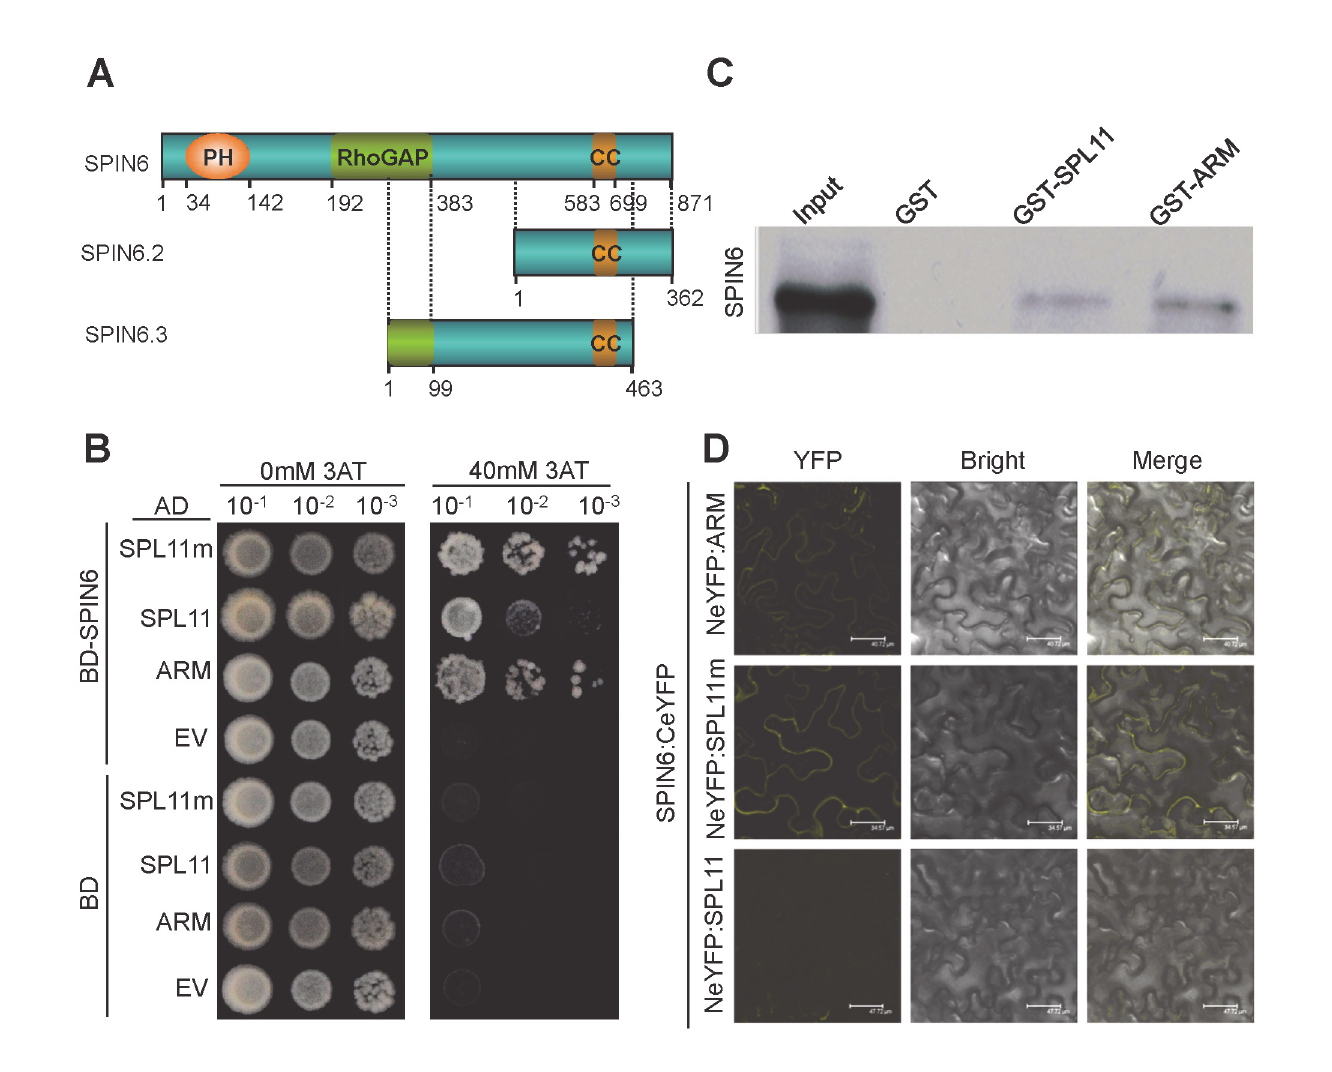
Figure 1. SPIN6 is a Rho GTPase-activating protein (RhoGAP) and interacts with SPL11 in vitro and in vivo . (A) The protein structure of SPIN6, SPIN6.2 and SPIN6.3. The position of the Pleckstrin Homology (PH) domain (34 – 142), RhoGAP domain (192 – 383), and coiled coil (CC) motif (583 – 699) are indicated. (B) SPIN6 interacts with SPL11 in yeast. SPL11 represents the full-length SPL11; ARM is the ARM domain of SPL11; and SPL11m is the SPL11 mutant with a three amino-acid deletion at C314P315T316 in the U-box domain, resulting in a loss-of-function of E3 ligase activity (Zeng et al., 2004). After they were diluted 10, 100, and 1000 times with sterilized-distilled H 2 O, the Mav203 yeast transformants were plated on synthetic dextrose medium without Trp, Leu, and His amino acids (SD-LTH) and with 0 mM or 40 mM 3-amino-1,2,4,-triazole (3AT), separately. (C) SPIN6 binds to SPL11 in the GST pull-down assay. His:SPIN6 and GST:SPL11, GST:ARM of SPL11 were used in the assay. (D) SPIN6 interacts with SPL11 in N . benthamiana in BiFC assay. SPIN6 was fused with the C-terminal of eYFP to make SPIN6:CeYFP. SPL11, ARM, and SPL11m were fused with the N-terminal eYFP to make NeYFP:SPL11, NeYFP:ARM, and NeYFP:SPL11m,